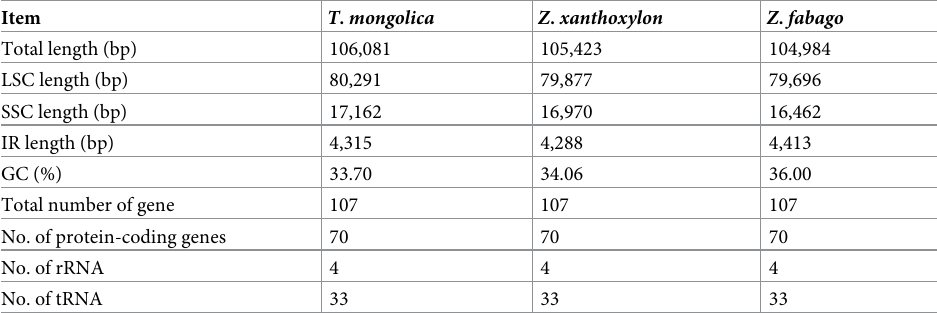
Table 2. Summary of major features of the three chloroplast